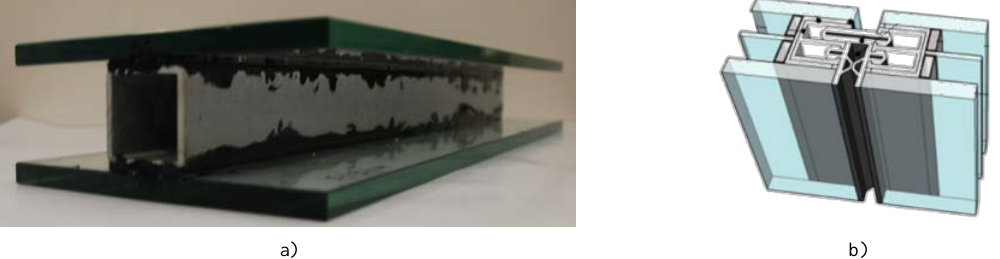
Fig. 2 Frame-integrated GFRP-glass sandwich components in a) beam configuration (experimental specimen from (Pascual et al., 2017) and b) unitised panel configuration (schematic view on the connections between two adjacent units from (Cordero,